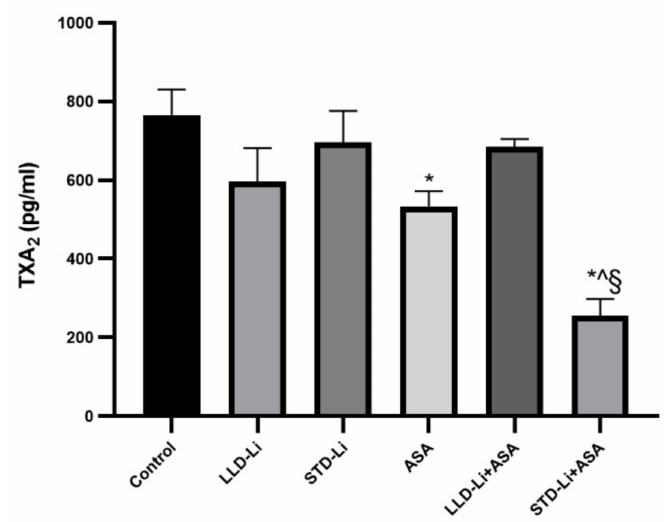
Figure 9. Plasma TXA2 in aspirin + lithium-treated rats. Rats were fed regular food (control) or lithium-containing food [LLD-Li or STD-Li] for 42 days. Low-dose ASA (1 mg/kg, ip) was administered alone or together with Li. On day 42 rats were sacrificed, blood collected, serum separated, and TXA2 levels determined by ELISA as described in Materials and Methods. Results are the means ± SEM of a single representative experiment out of two demonstrating a similar pattern with 6–8 rats per group in the depicted experiment. Two-way ANOVA: ASA effect, F 1,40 = 4.204, p = 0.046; Li effect, F 2,40 = 5.071, p = 0.01; aspirin x Li interaction: F 2,40 = 3.312, p = 0.046. Post hoc Fisher’s LSD test: Control vs. LLD-Li, p = 0.107; Control vs. STD-Li, p = 0.077; Control vs. ASA, p = 0.048; Control vs. LLD-Li + ASA, p = 0.426; STD-Li vs. STD-Li + ASA, p = 0.0135; ASA